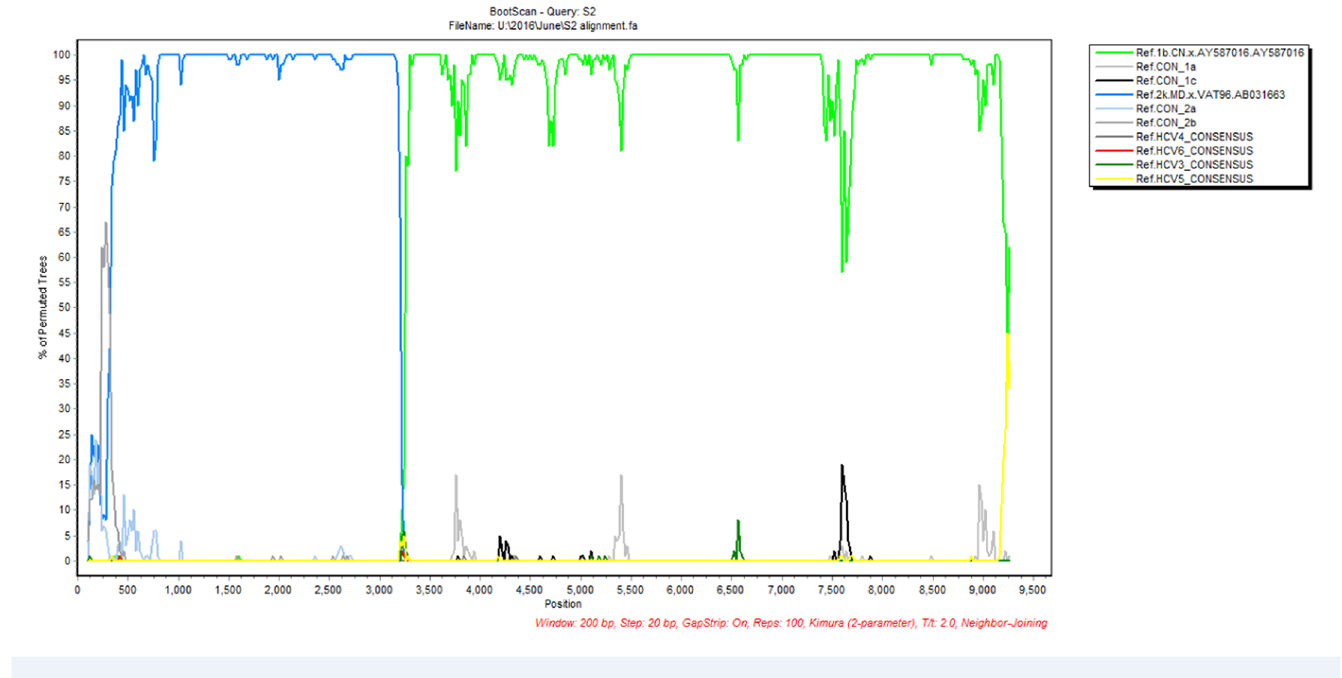
Fig 1. BootScan plot of percentage permuted trees over nucleotide position across the full length of one of the HCV 2k/1b recombinant strains. Different colors represent sequencesof different genotypes/subtypes.